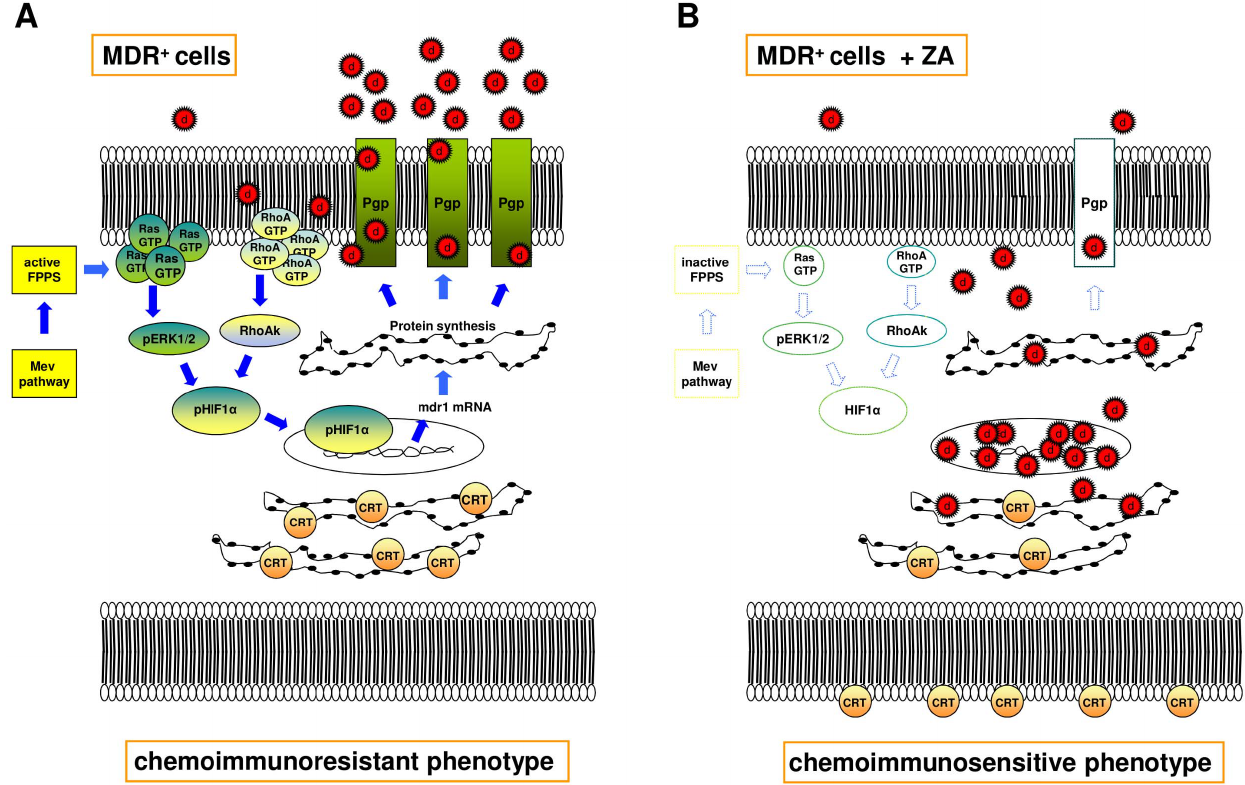
Figure 7. Schematic drawing of mechanisms operated by ZA to reverse chemoresistance and immune-resistance. A . The accelerated Mev pathway in MDR + cells leads to the constitutive activation of Ras/ERK1-2 and RhoA/RhoA kinase downstream signalling pathways which culminates into HIF-1 a activation and plasma membrane Pgp expression. The higher amounts of plasma membrane-associated cholesterol in MDR + cells also contribute to the functional Pgp activation. The higher efficiency to extrude Dox protects MDR + cells from cytotoxicity and ICD epitomized by CRT exposure on the cell surface. B . By inhibiting the Mev pathway, ZA downregulates the Ras/ERK1-2 and RhoA/RhoA kinase signalling pathways, and decreases the HIF-1 a -induced transcription of Pgp. As a result, Dox accumulates inside MDR + cells at sufficient amounts to induce cytotoxicity and promote CRT exposure, turning the phenotype of these cells from a chemoimmunoresistant phenotype into a chemoimmunosensitive